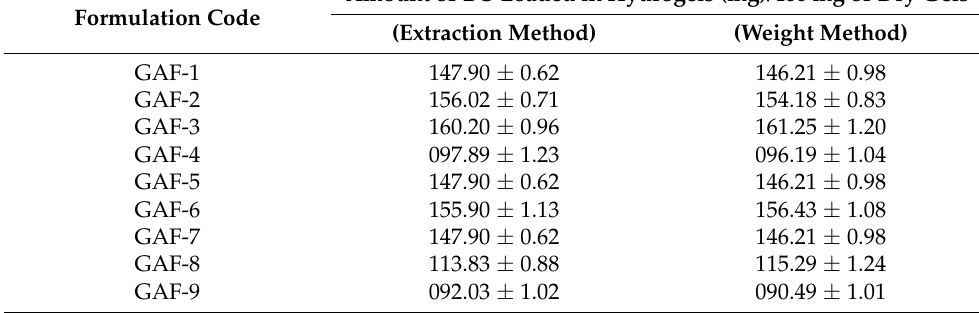
Table 2. Drug loading of GAcPAAc